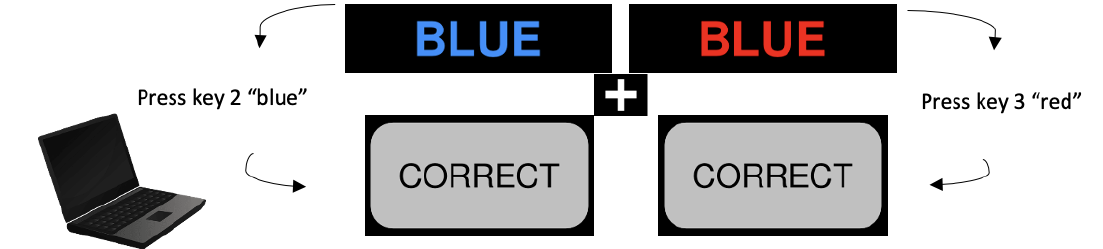
Figure 3. Computerised Stroop test (PsyToolkit) visual representation.